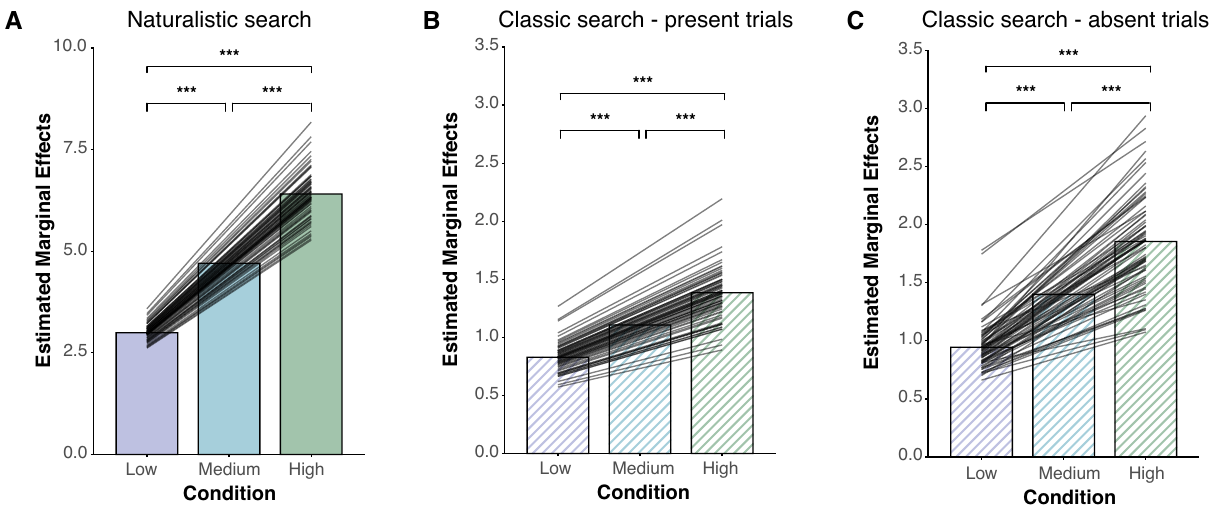
Figure 3. Experimental results. ( A ) Visual clutter modulates reaction times in real-world environments ( F (2,368.76) = 187.42, p < 0.001). Set size modulates reaction times on both ( B ) present trials ( F (2,116.08) = 463.04, p < 0.001) and ( C ) absent trials ( F (2,105.09) = 309.66, p < 0.001) in a classic visual search task. Lines indicate random slope fits for each participant. * p < 0.05, ** p < 0.01, *** p < 0.001, n.s. p >